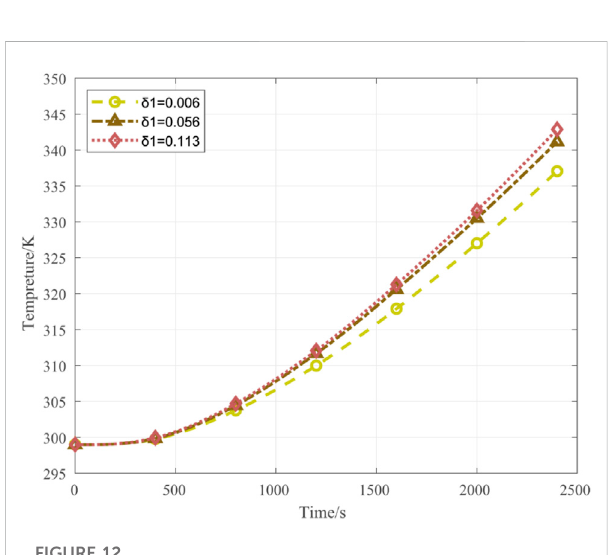
FIGURE 12 Effect of the distance δ 1 between the front door and the battery regiononthelowesttemperatureinthedryingcabinetasafunctionof simulation